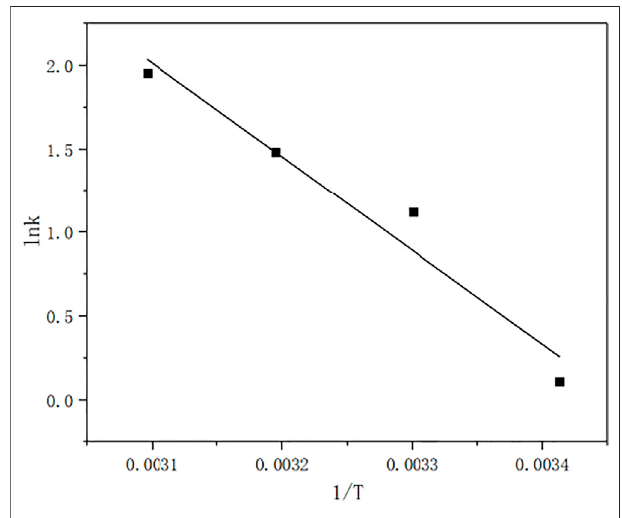
FIGURE 13 | Residual analysis.